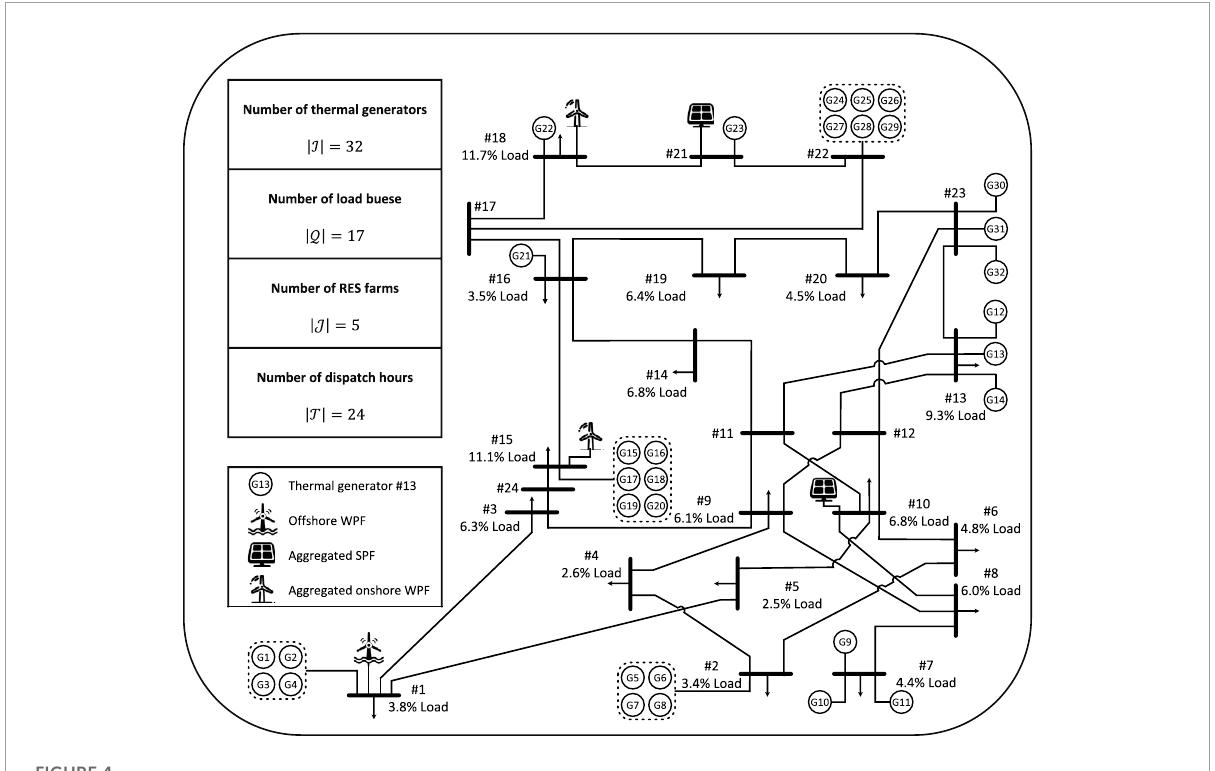
FIGURE 4 The structure of the IEEE 24-bus system.